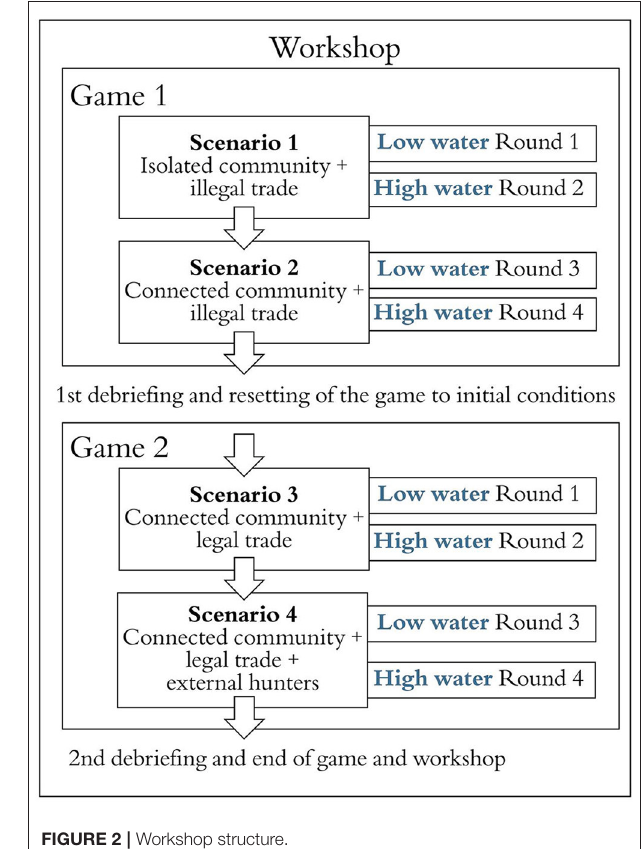
FIGURE 2 | Workshop